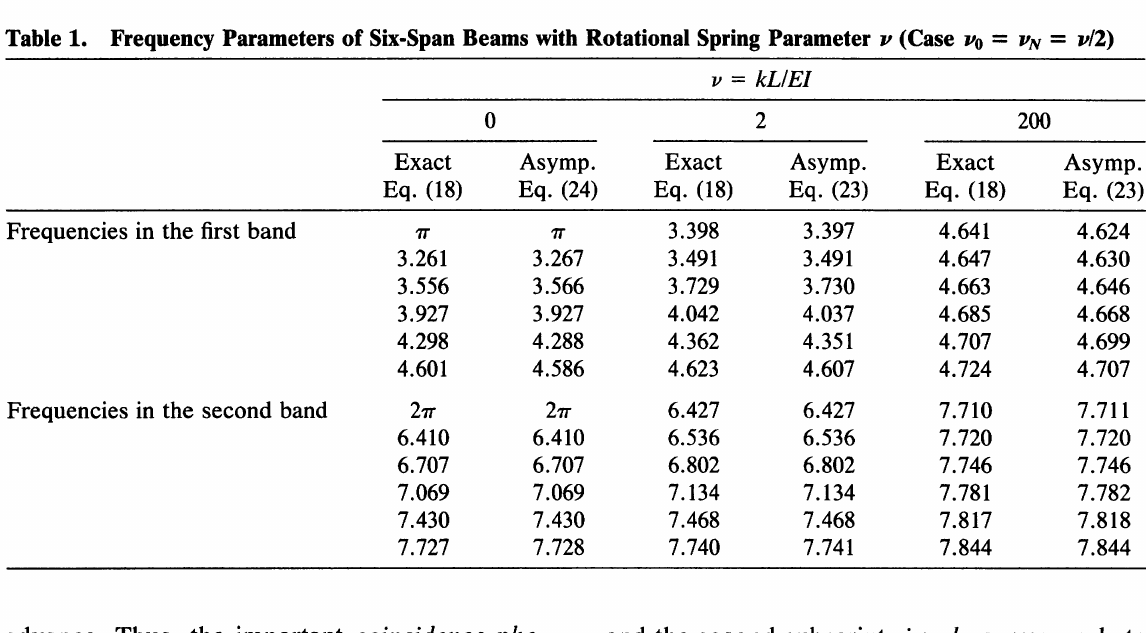
Table 1. Frequency Parameters of Six-Span Beams with Rotational Spring Parameter v (Case Vo Frequencies in the first band 1f 1f